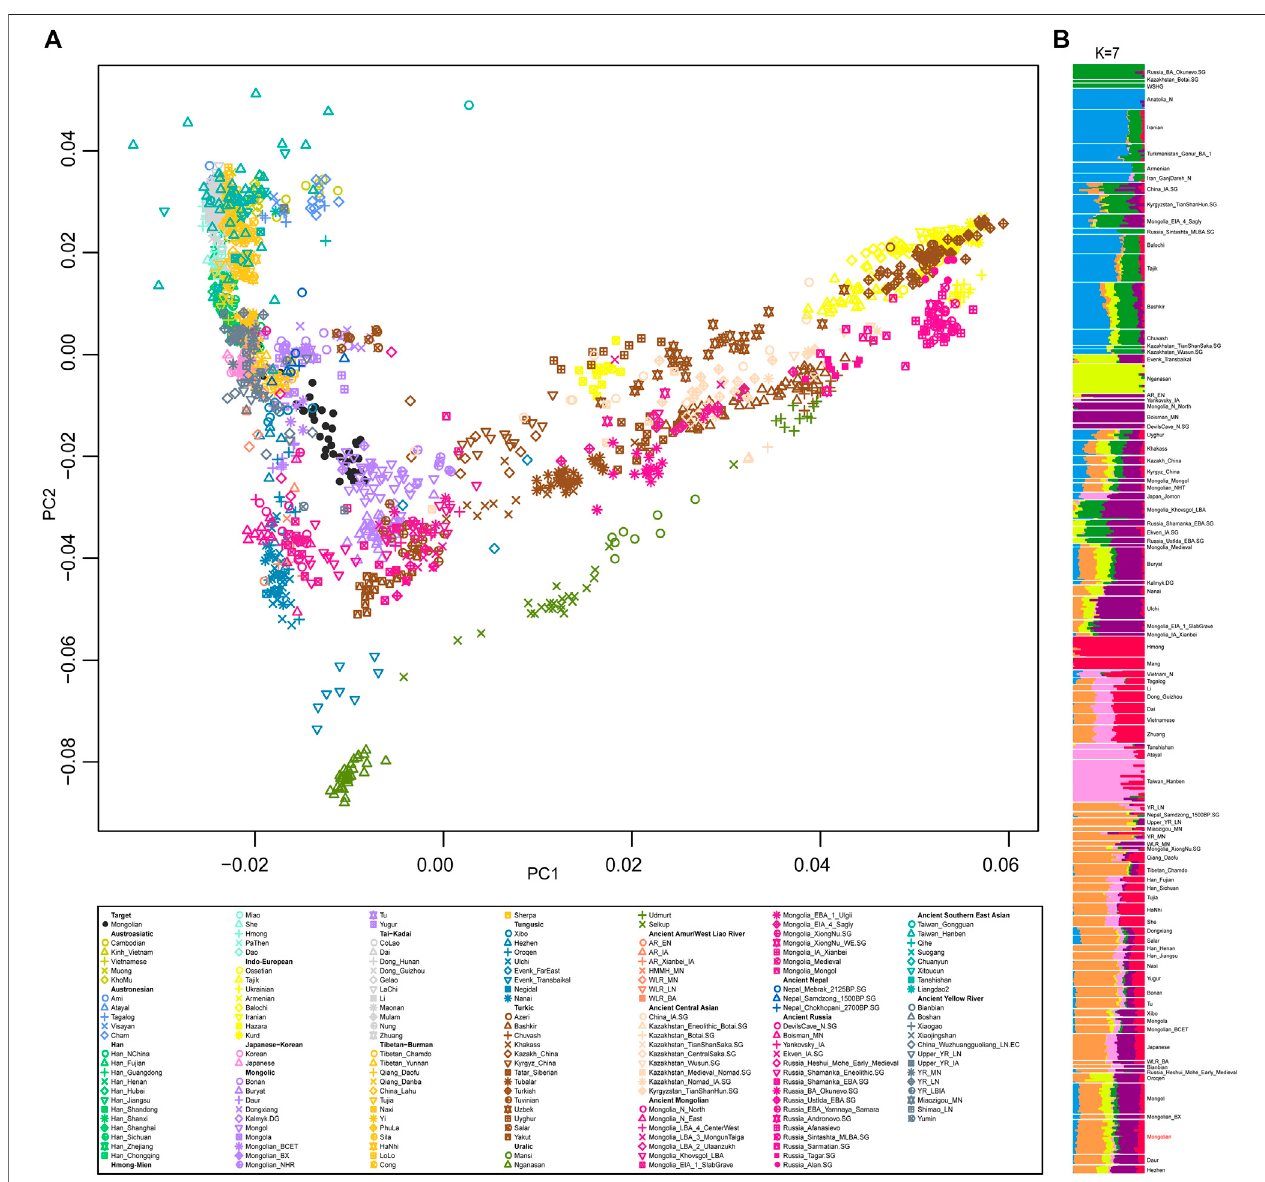
FIGURE 1 | The population structure of modern and ancient populations in Eurasia based on genome-wide data. (A) . PCA result showed an overview population relationship between modern populations and ancient populations. (B) . ADMIXTURE results (the lowest CV errors K (cid:1) 7): ancestral components among Mongolian and modern and ancient populations in